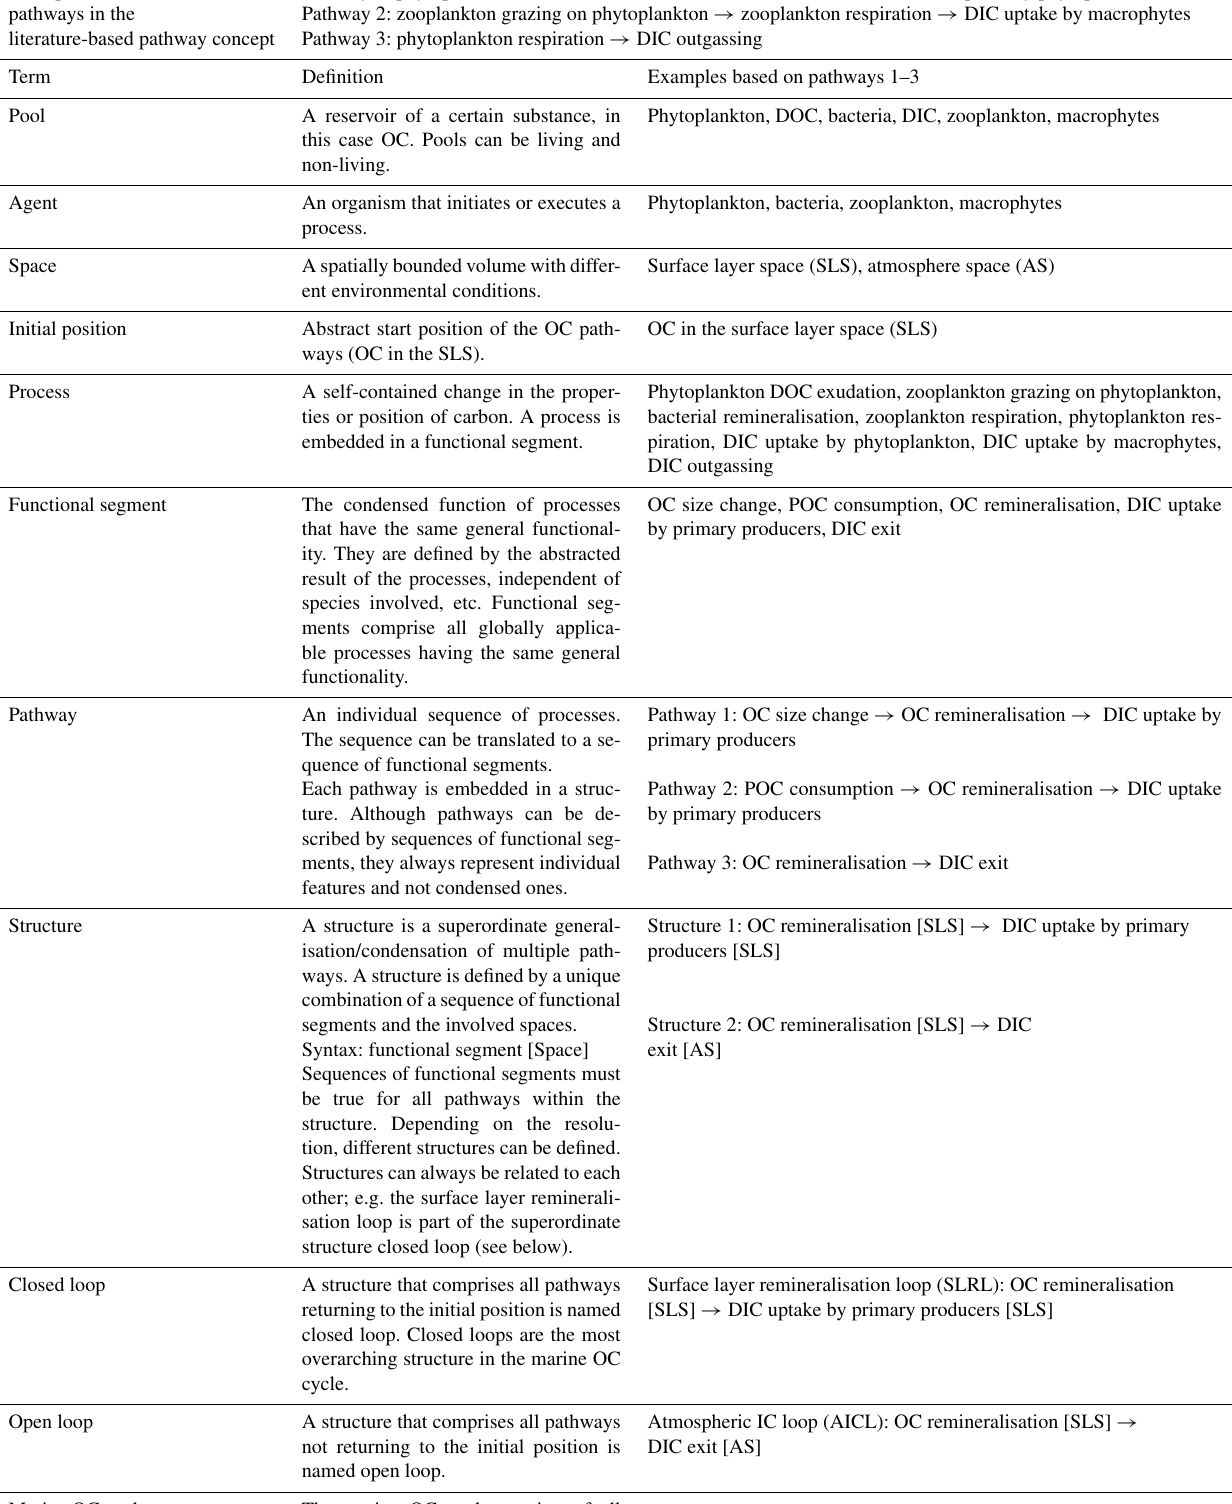
Table 1. Definitions and examples of relevant terms based on three individual